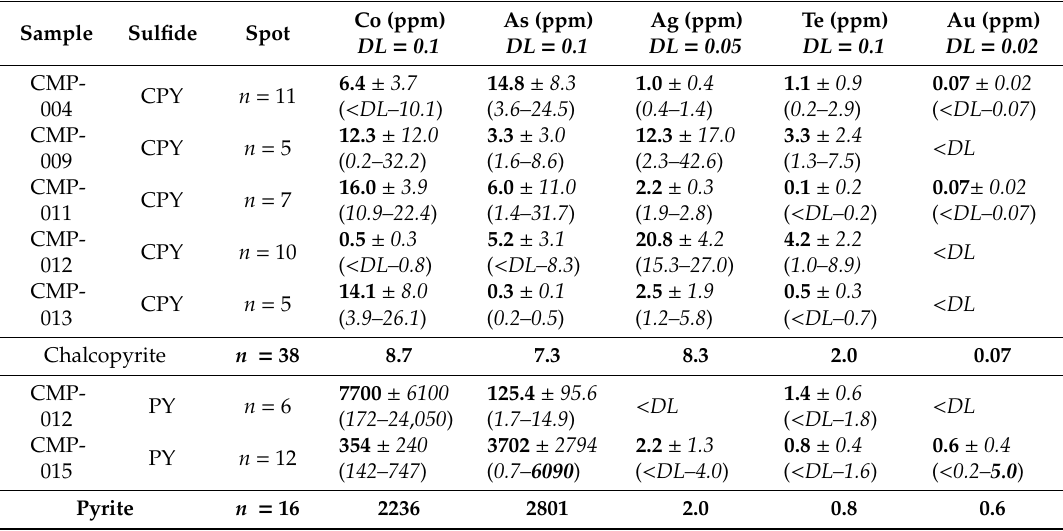
Table 2. Concentrations for Co, As, Ag, Te, and Au (in ppm) determined by in situ LA-ICP-MS analysis on selected chalcopyrite and pyrite